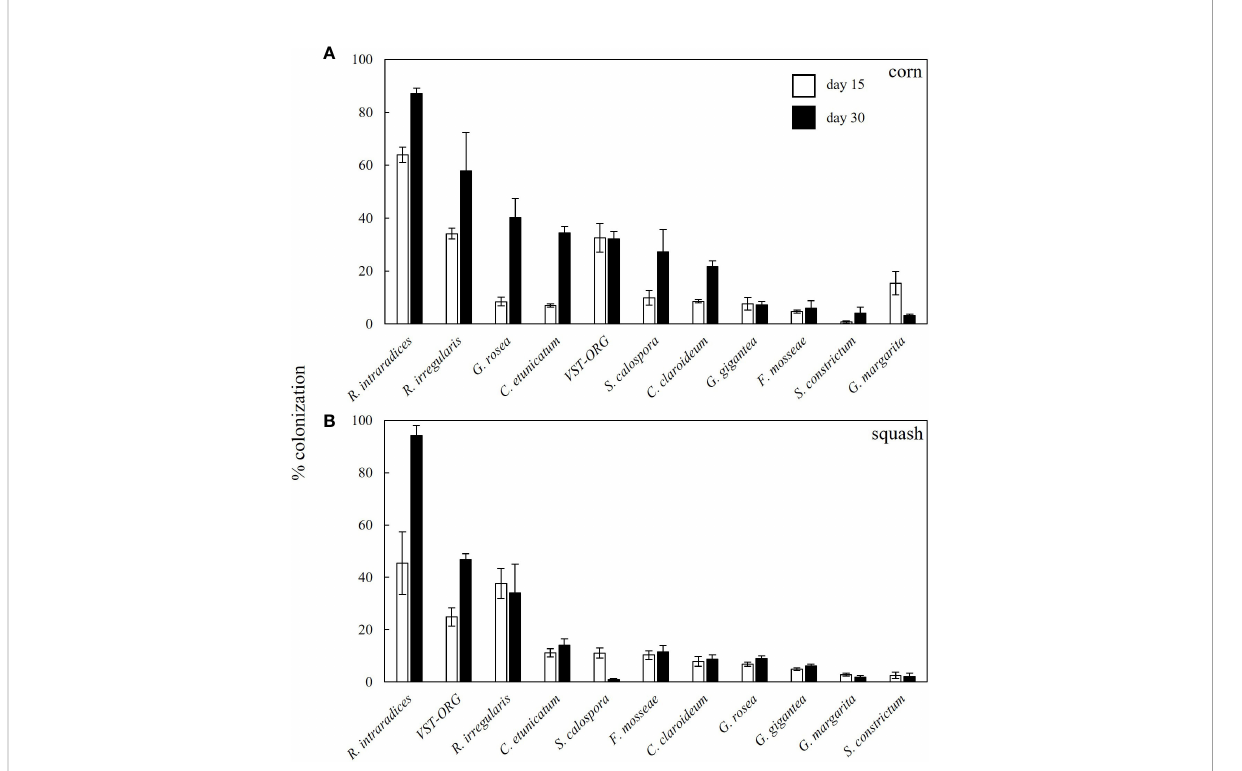
FIGURE 1 Percent colonization of roots varied across AMF inocula. Percent colonization values of (A) corn and (B) squash roots. Valued are means (n=5 plants) presented with standard error as measured fi fteen days after planting (open bars) and 30 days after planting (black